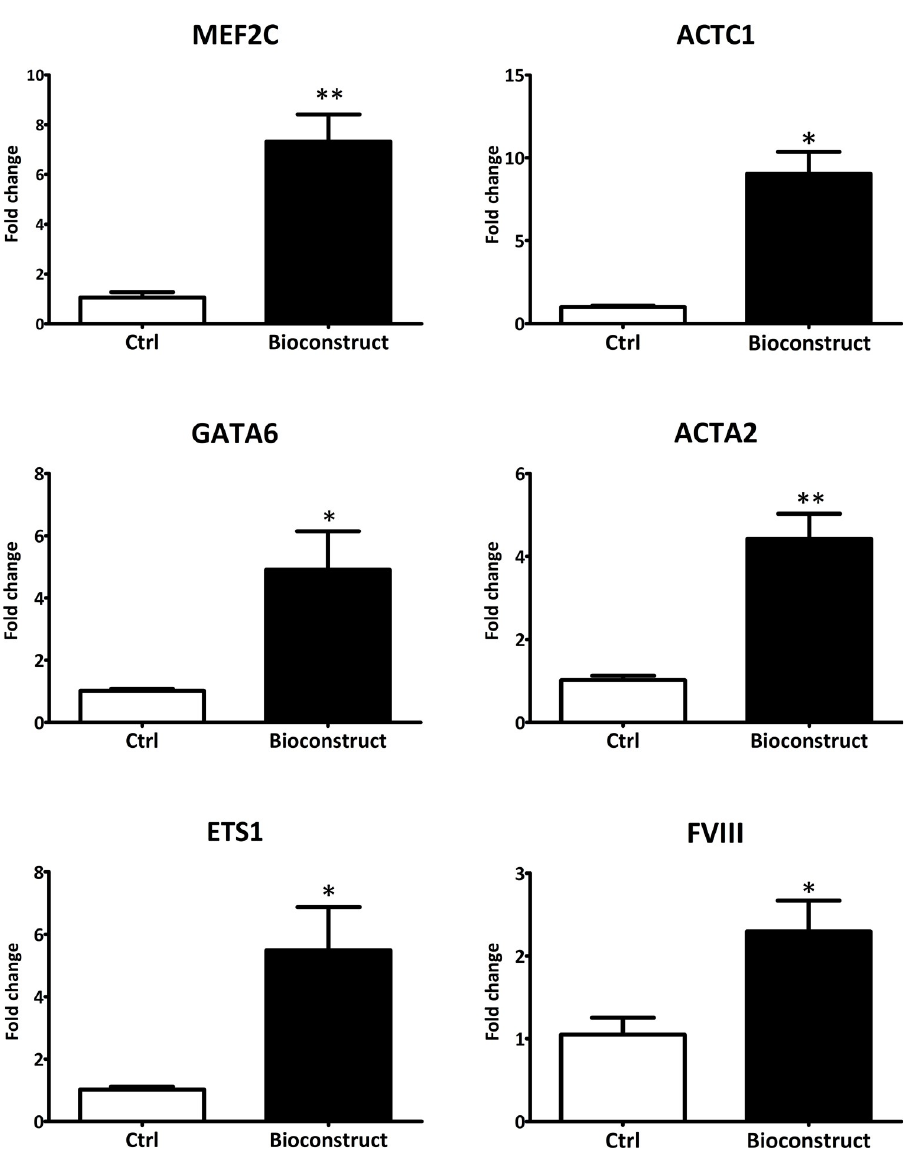
Fig 6. Gene expression analysis of cardiac cell markers in hCPCs culterd on d-ECM or on plastic. Real-time PCR analysis for cardiac gene expression showed an upregulated transcription of cardiomyocyte markers MEF2C and ACTC1 (7.320 ± 1.096 and 9.053 ± 1.305), smooth muscle cell markers GATA6 and ACTA2 (4.903 ± 1.245 and 4.423 ± 0.6064) and endothelial cell markers ETS1 and FVIII (5.480 ± 1.394 and 2.297 ± 0.3720) ( � p � 0.05; �� p �